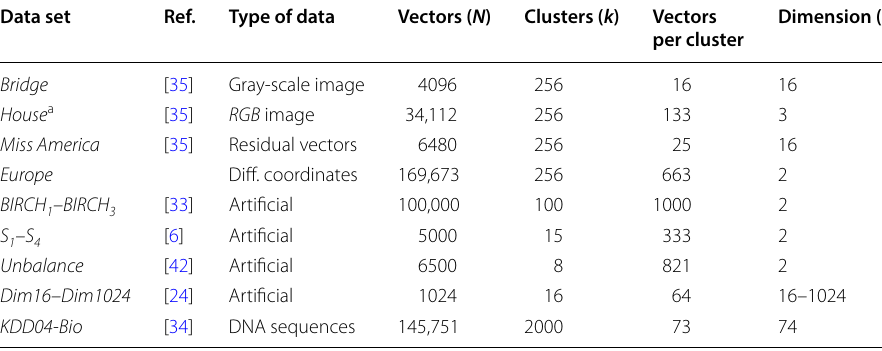
Table 2 Summary of the Data